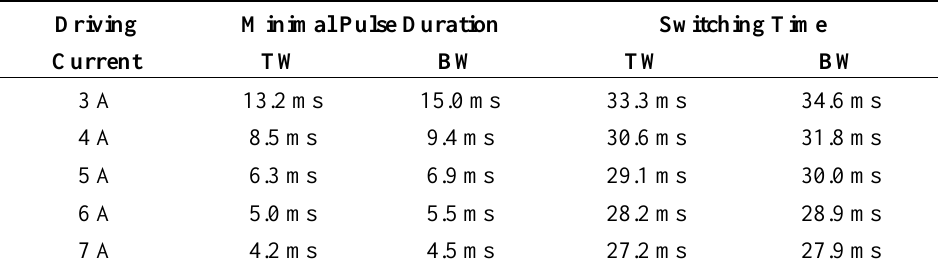
Table 2. Minimal pulse duration and corresponding switching time.